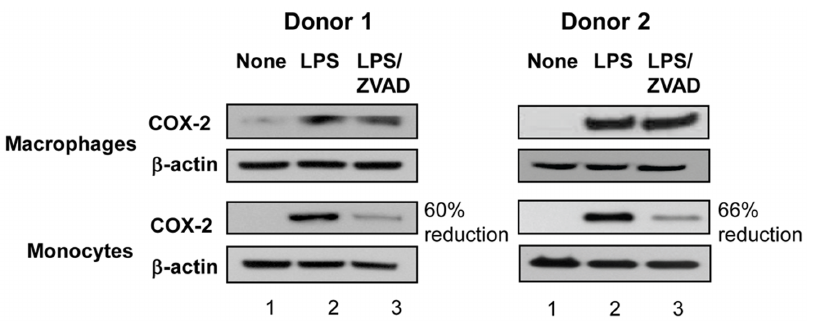
Figure 2. ZVAD reduced COX-2 protein expression in monocytes but not in macrophages. Macrophages and monocytes were obtained from Donor 1 and Donor 2 and were left untreated (lane 1) or were incubated with LPS at 20 ng/ml in the absence (lane 2) or in presence of ZVAD (lane 3) for 12 h. Cells were lysed in 1% NP40 and proteins were analyzed by SDS-PAGE (12 and 16 m g protein per lane for monocytes and macrophages, respectively) and Western Blotting with Abs against COX-2 (panels 1 and 3 from the top) or with b -actin as loading control (panels 2 and 4 from the top). Densitometry was performed on developed films and percent reduction of COX-2 protein expression in LPS-treated monocytes in the presence of ZVAD was calculated relative to the expression of COX-2 in monocytes treated with LPS